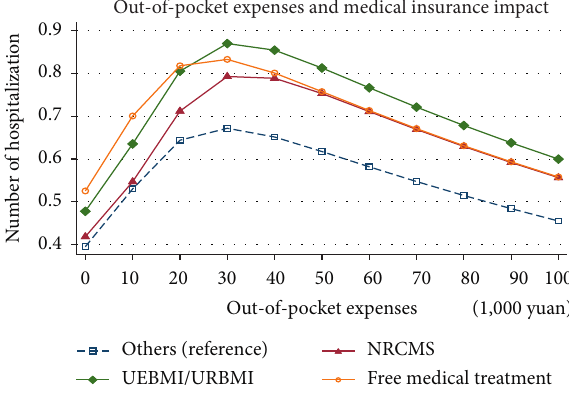
Figure 7: Out-of-pocket expenses and medical insurance